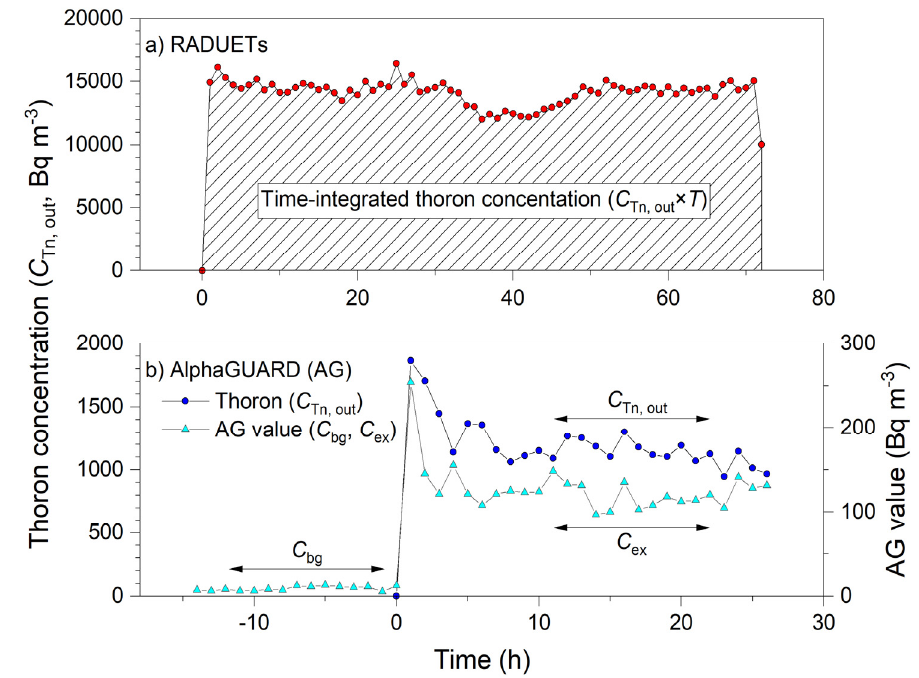
Figure 3. Examples of temporal variations in thoron concentration in the thoron calibration chamber during exposures of the RADUETs ( a ) and the AlphaGUARD ( b ) to thoron. In ( b ), values indicated by the AlphaGUARD are also shown. Meanings of symbols are the same as those in Equations (3) and (4). Table 2. Results of exposure of RADUETs and AlphaGUARD to thoron under variable wind speeds in the thoron calibration chamber.